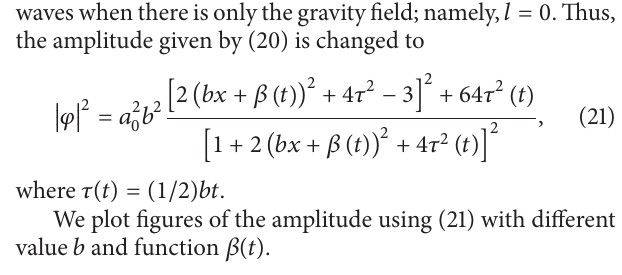
whose amplitude can be written